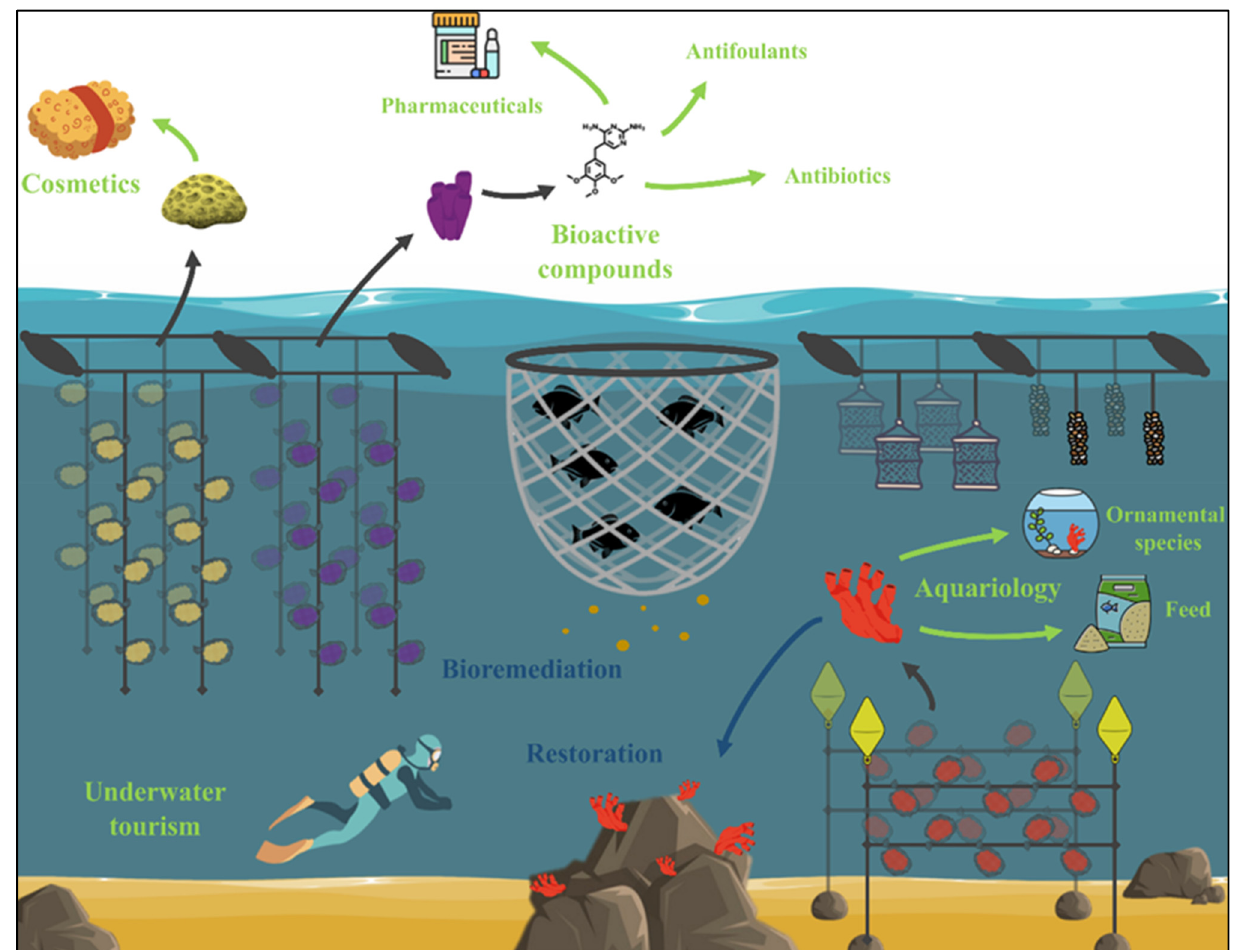
Figure 6. Sponges as a by-product of an IMTA system. Environmental and economic benefits are represented in blue and green, respectively.